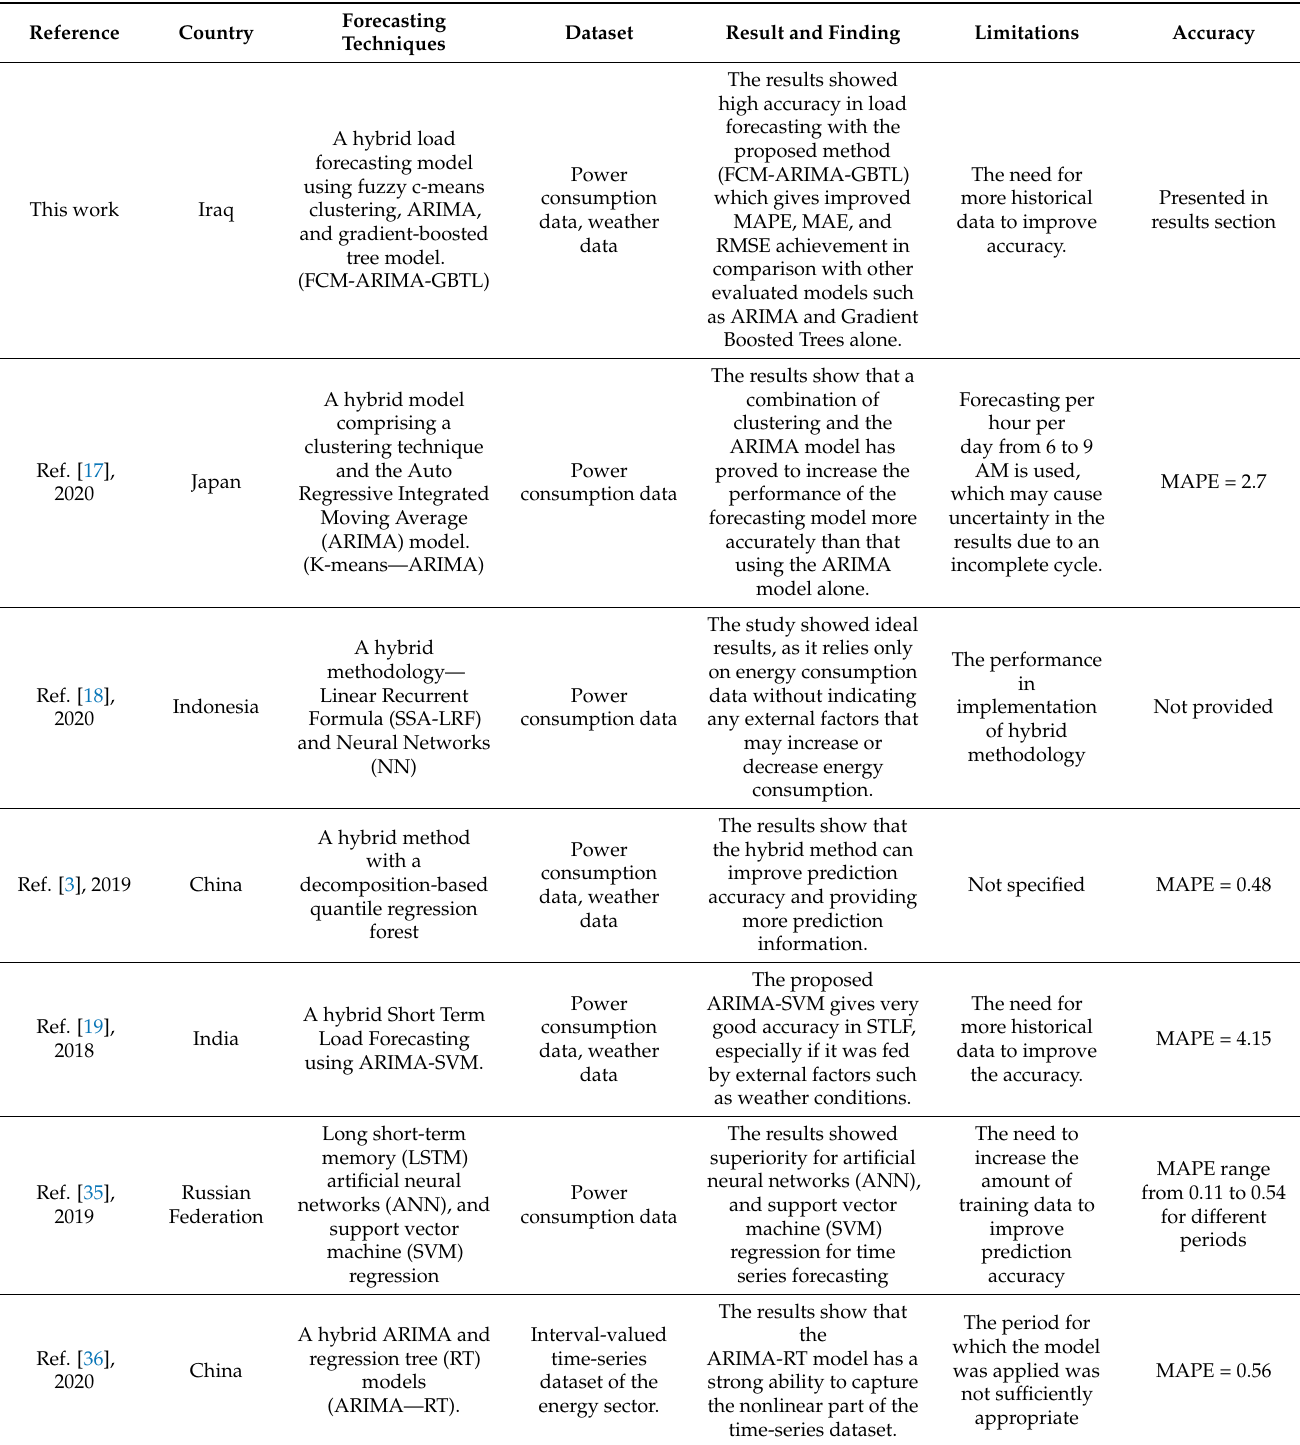
Table 1. Summary of Most Recent Short-Term Forecasting